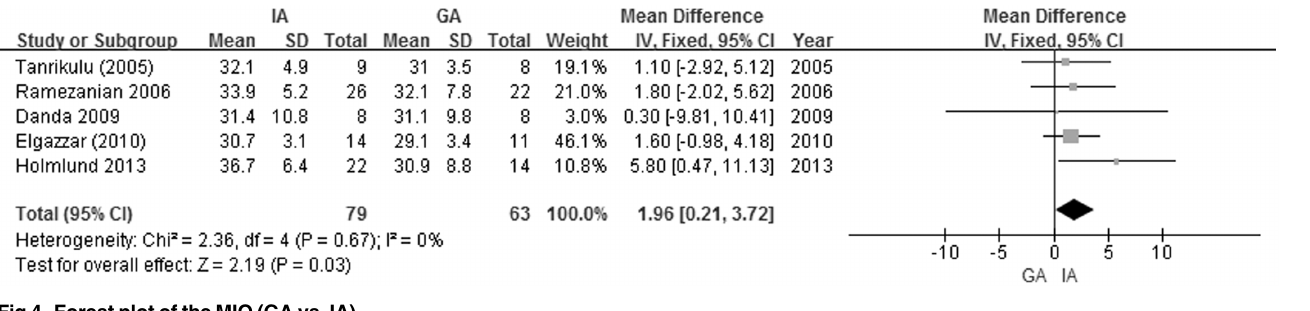
Fig 4. Forest plot of the MIO (GA vs. IA).